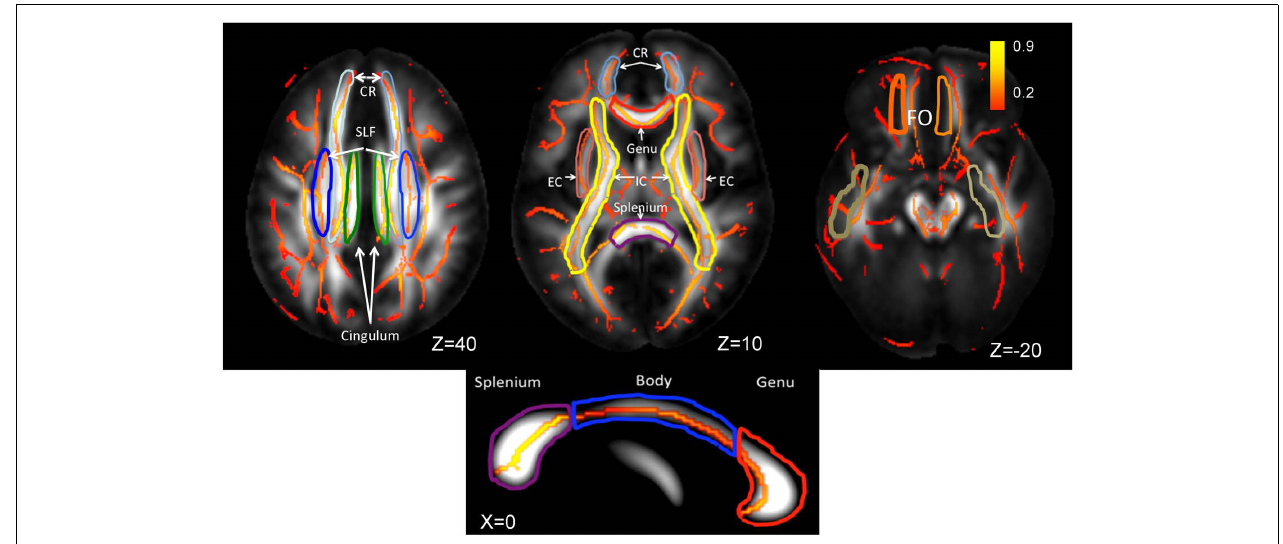
the genu, body, and splenium of corpus callosum.The population-wise average FA values are color coded on the skeleton of the tract.The location of the axial slices (the Z-coordinate) is provided in theTalairach reference frame. The three segment of corpus callosum are shown on the mid-sagittal slice (Talairach X = 0).